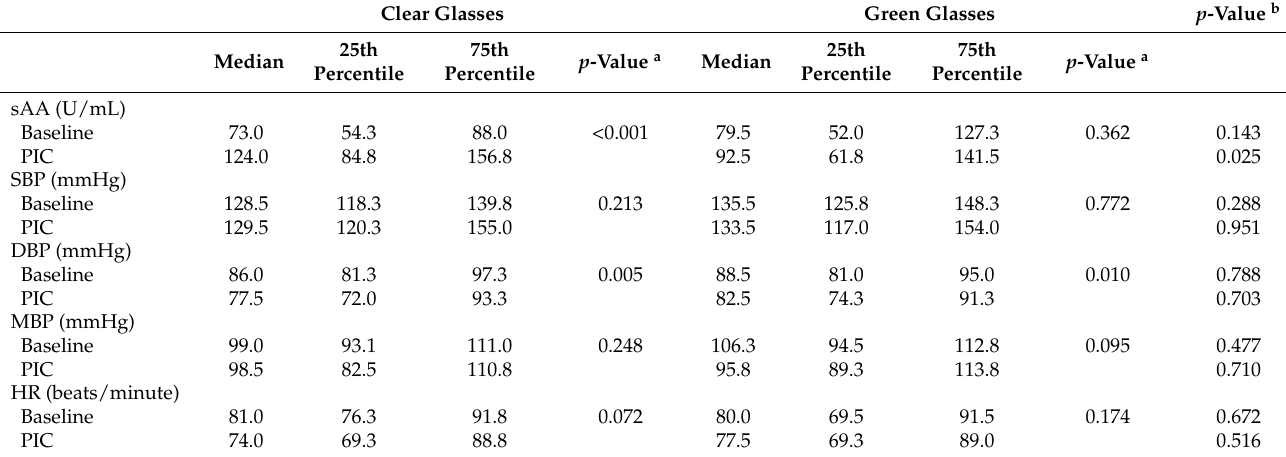
Table 2. Values for salivary alpha-amylase activity, blood pressure, and heart rate in patients in the clear group and patients in the green